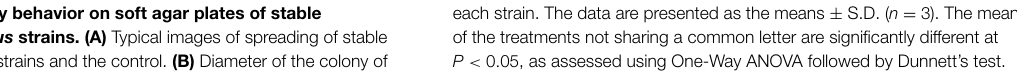
FIGURE 7 | The motility behavior on soft agar plates of stable silenced V. alginolyticus strains. (A) Typical images of spreading of stable silenced V. alginolyticus strains and the control. (B) Diameter of the colony of